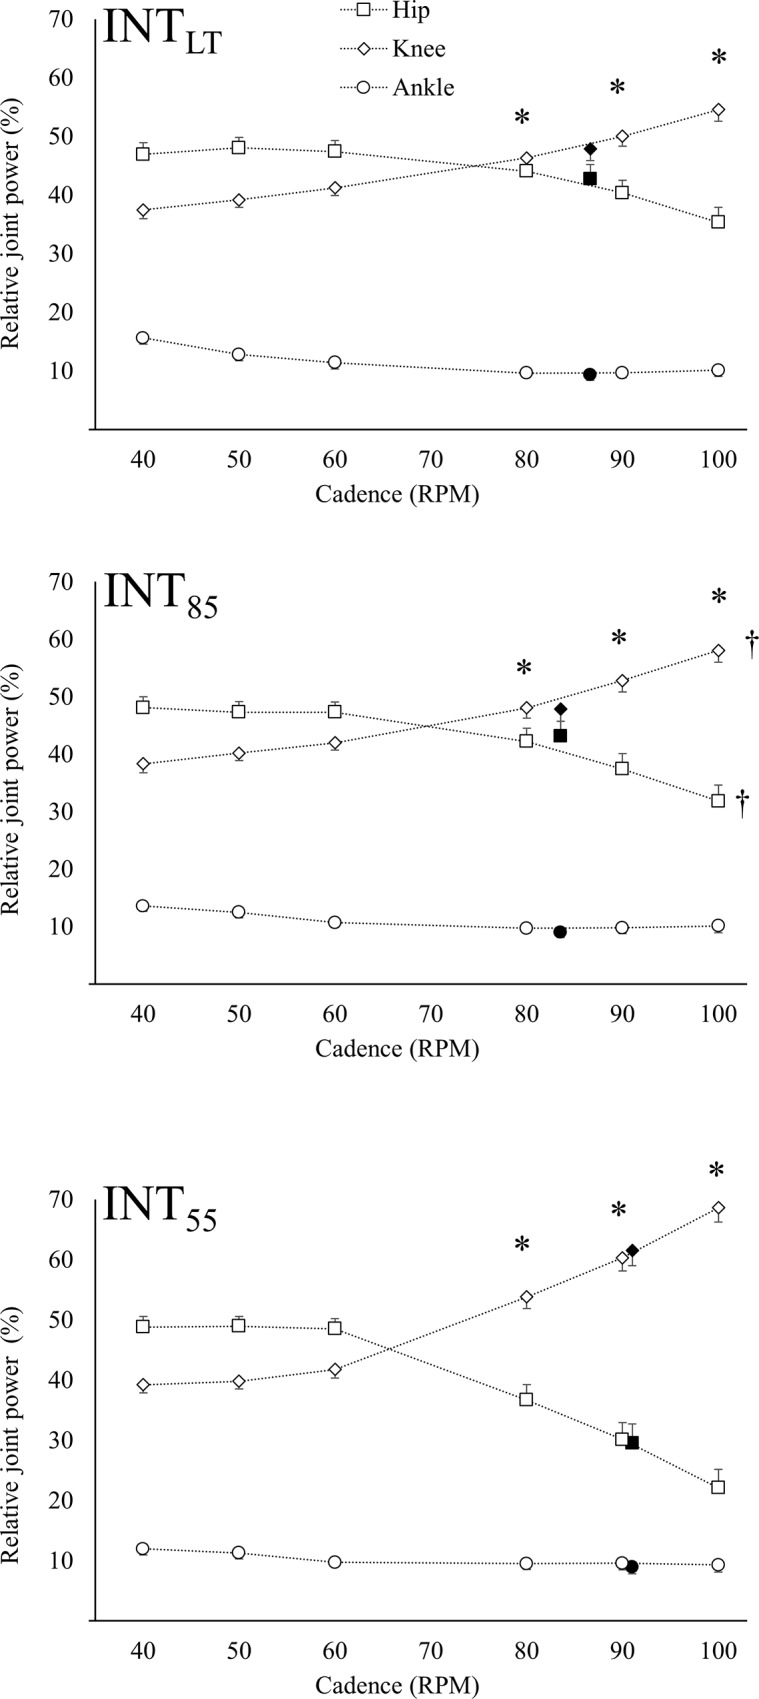
Relative joint power for hip, knee and ankle joint actions.Group mean and standard error for relative joint power in hip (square), knee (diamond) and ankle (circle) joint at Int55, Int85 and IntLT. Filled marker indicate FCC. * indicate a difference in joint power from previous cadence for the hip and knee joints. Daggers indicate a difference in the mean relative joint power from previous intensity.